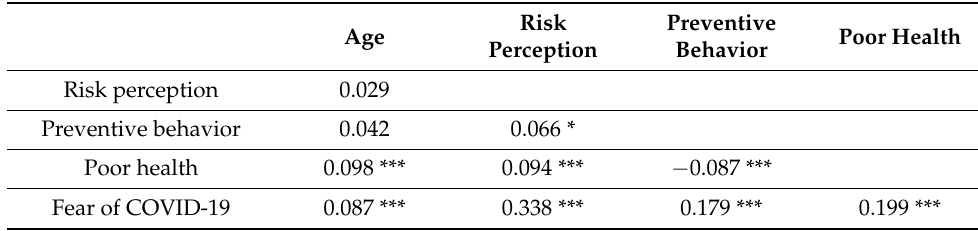
Table 2. Correlation between age, risk perception, preventive behavior, and fear of COVID-19 (N = 1484).